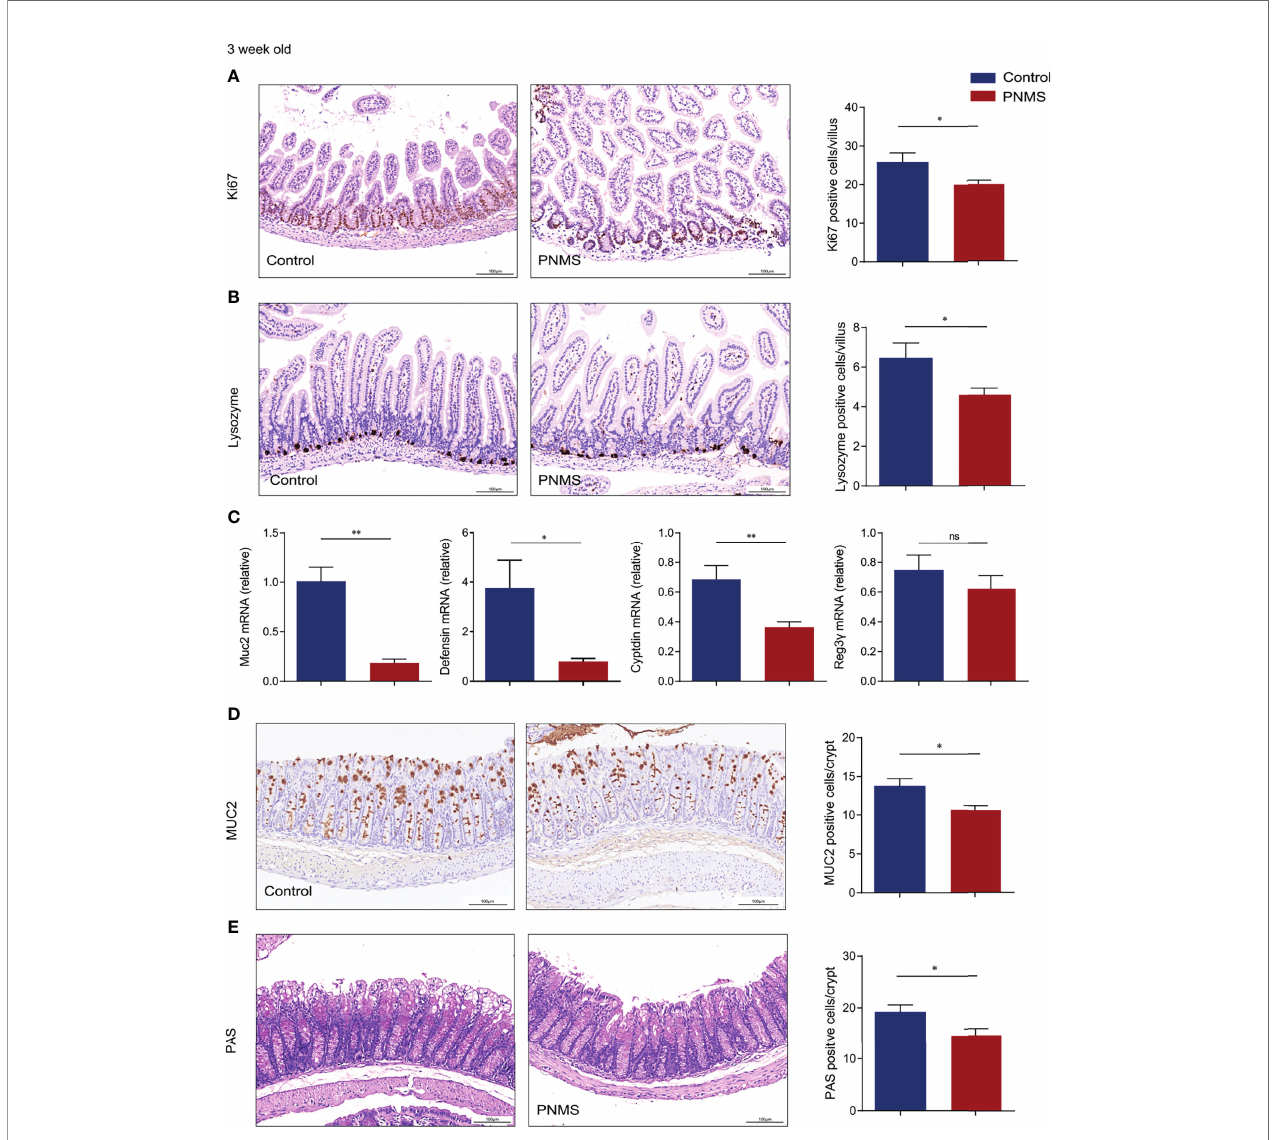
FIGURE 2 | Prenatal maternal stress inhibited the proliferation and differentiation of the intestinal tract in 3-week-old offspring mice. (A) Cell proliferation in the small intestine was assessed through Ki-67 immunohistochemical staining. (B) Paneth cells in the small intestine were evaluated by lysozyme immunohistochemical staining and the quanti fi cation of positively stained cells. (C) Relative mRNA expression levels of Muc2 in the colon and defensin, cryptdin, and Reg3 g in the small intestine. (D) Immunohistochemical staining for MUC2 mucin ( brown ) in colon tissue section. (E) Periodic acid – Schiff (PAS) staining for goblet cells in colon tissue. Quanti fi cation of positive cells per villus as shown by the histogram. At least 100 villi were randomly selected for each sample for calculation. PNMS , prenatal maternal stress. Scale bar , 100 m m. Magni fi cation, ×200. * p < 0.05, ** p < 0.01, ns p > 0.05. PNMS ( n = 6) vs . control ( n =